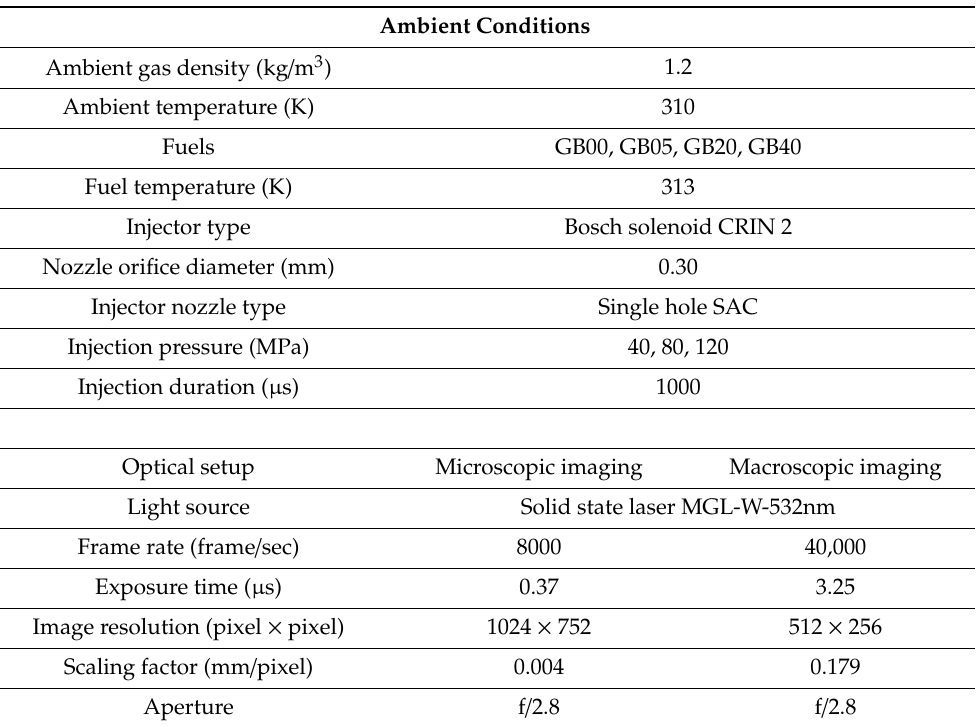
Table 2. Experimental conditions and optical setup for spray